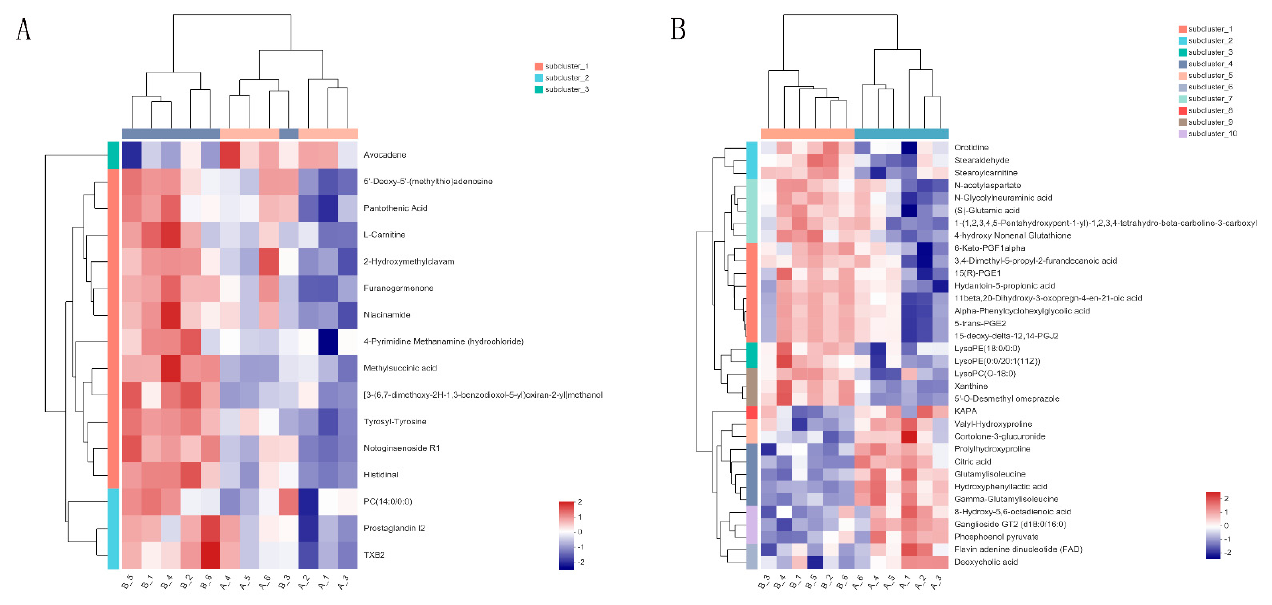
Figure 6. Heat maps of significantly different metabolites under positive ion mode ( A ) and negative ion mode ( B ), respectively ( n = 6). The color in the panel represents the relative levels of each metabolite: purple represents low levels, and red represents high levels. In maps, class ( A ) represented control samples and class ( B ) represented copper samples.